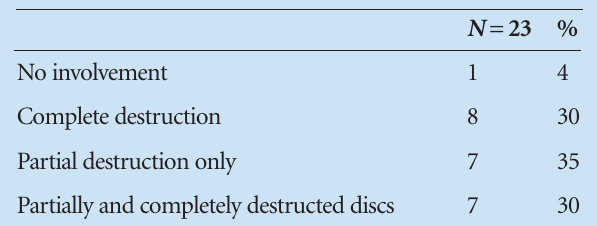
Table IV. Extent of disc involvement